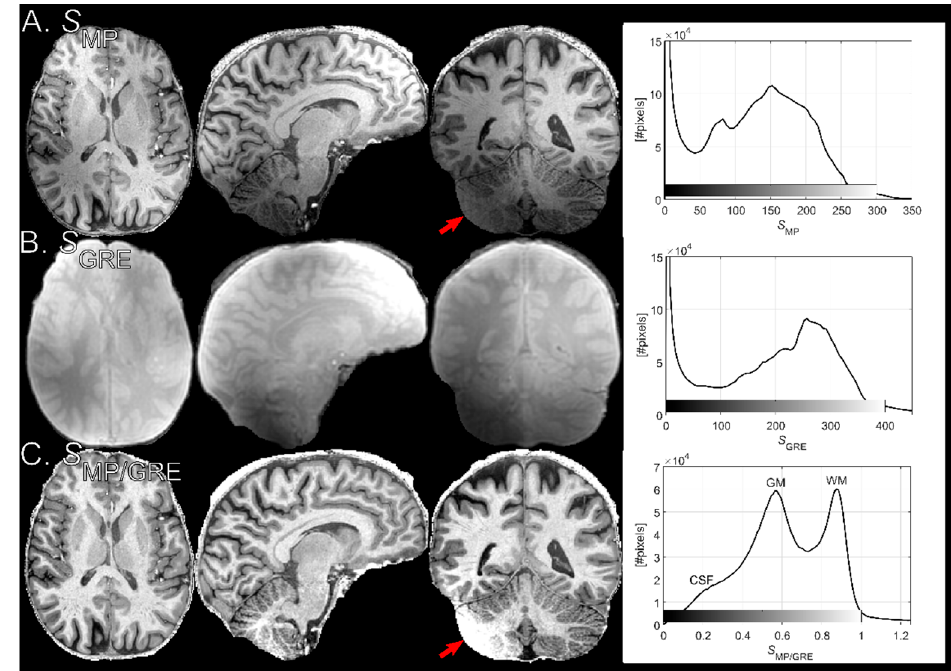
Figure 9. Example images acquired with the MPRAGE protocol before normalization ( A ), the reference GRE used for normalization ( B ), and the MPRAGE image after normalization ( C ). The right- hand panel shows whole-brain histograms of the respective images. Normalization clearly reduced spatial heterogeneity from B 1 . The improved homogeneity is also illustrated by the histograms, where GM and WM (and to a lesser extent CSF) modes are visible after normalization. In the right part of the cerebellum (red arrow, coronal plane), B 1+ is very weak, leading to failed adiabatic inversion.